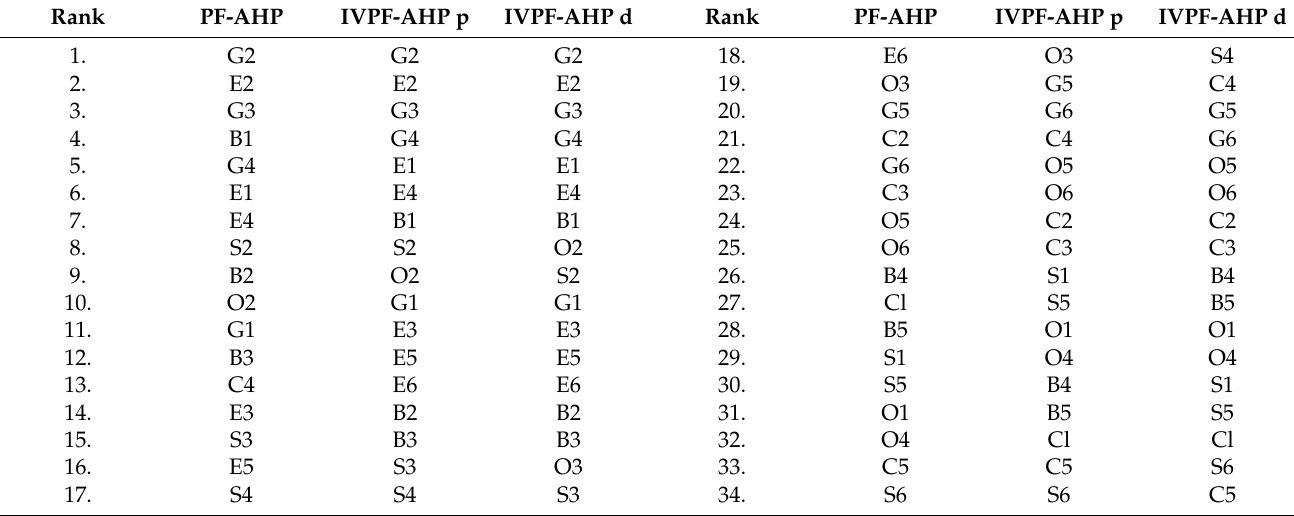
Table 17. Final ranking of